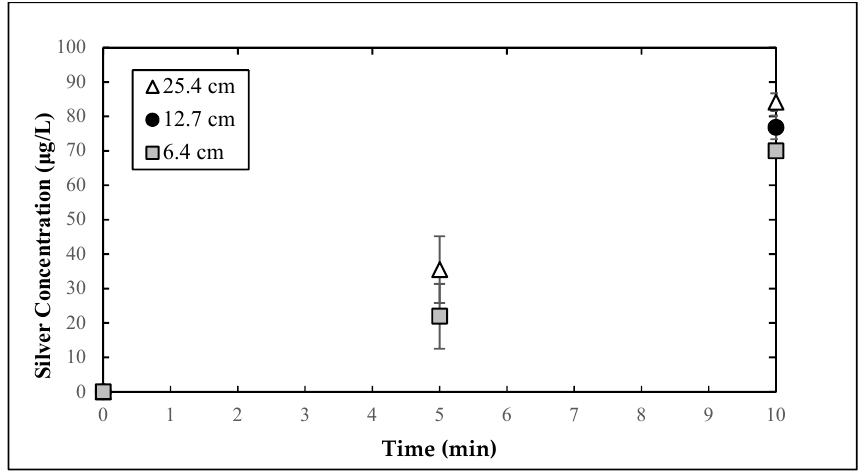
Figure 8. Silver ion concentration in 10 L synthetic groundwater as a function of time for 1 mm silver wires separated 6.4 cm, 12.7 cm, and 25.4 cm in an electrolytic apparatus. The ionic strength of the synthetic groundwater was 4.58 × 10 − 3 M. The average of three trials for each distance is shown in the graph with error bars indicating the standard error between the three trials. A trendline is included for each distance to depict the linear relationship between metal ion release and time.